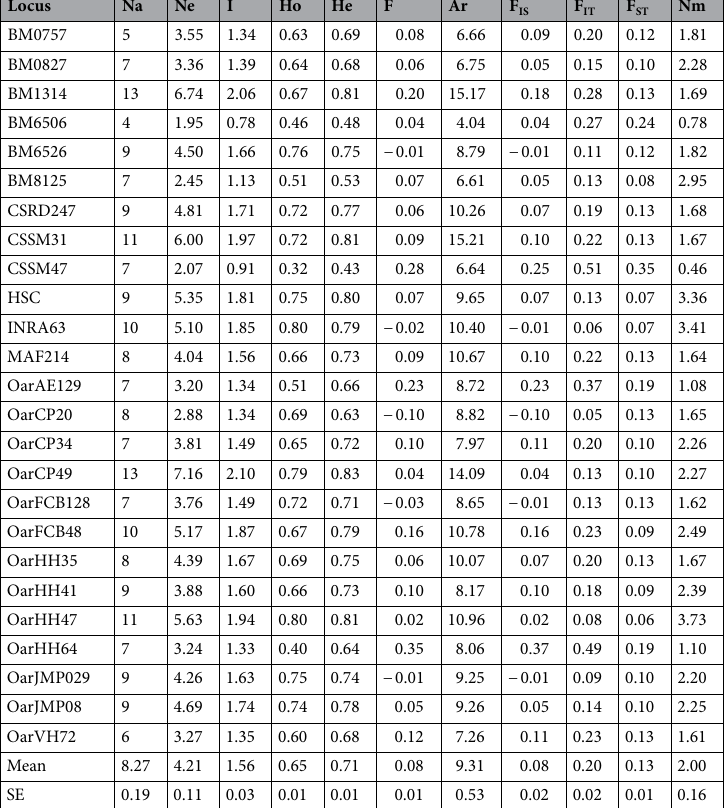
Table 3. Mean diversity indices, F-statistics (F IS , F IT , F ST ), and gene flow (Nm) values across 25 microsatellite markers in 11 Indian sheep breeds. Na = Observed number of alleles; Ne = Effective number of alleles; I = Shannon’s information index; Ho = Observed heterozygosity; He = Expected heterozygosity; F = Heterozygore deficiency/ inbreeding coefficient; Ar = Allelic richness; F IS , F IT , F ST = F-statistics values according to Weir and Cockerham 50